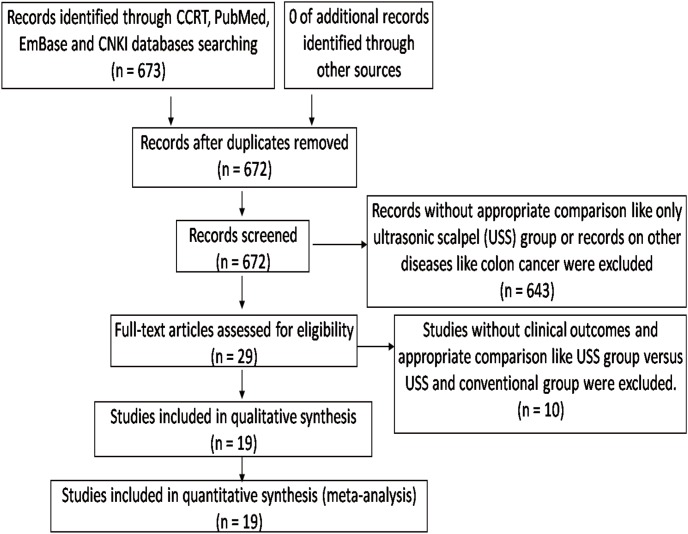
Literature search and selection procedure.